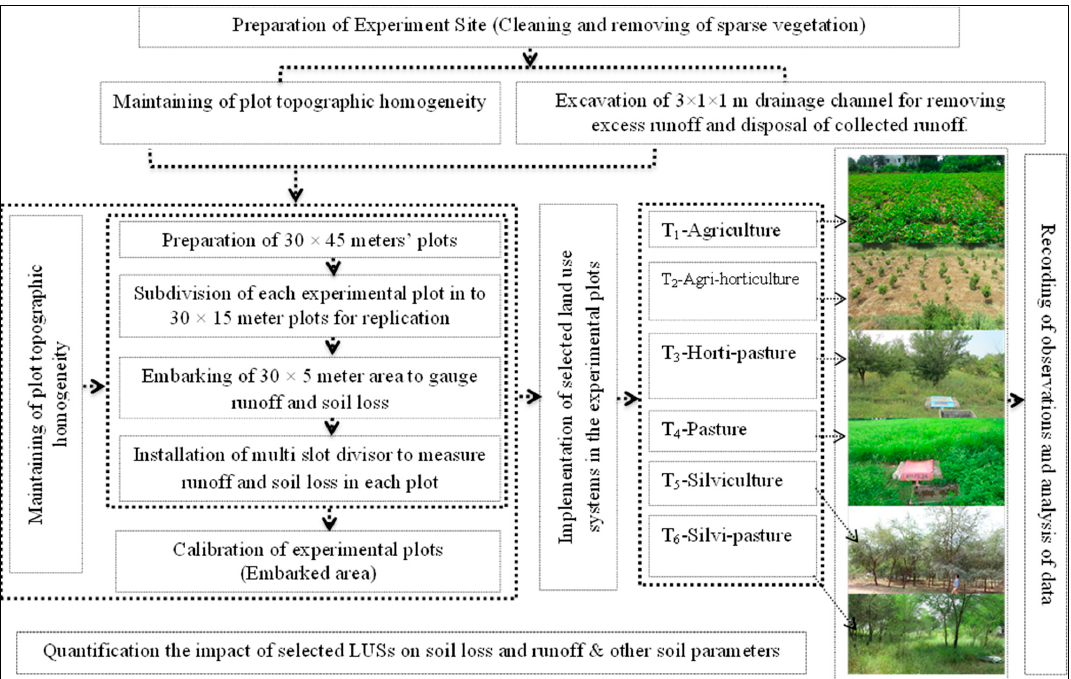
Figure 1. The geographical location of the experimental site in Kota district, Rajasthan, India.